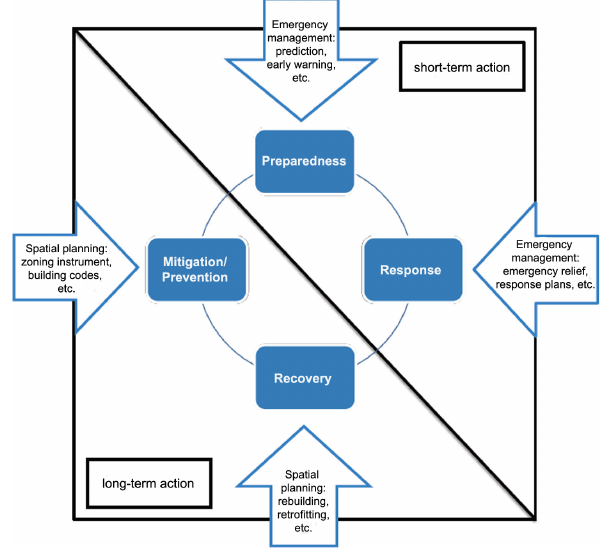
Figure 3. Short-term and long-term activities within the disaster management